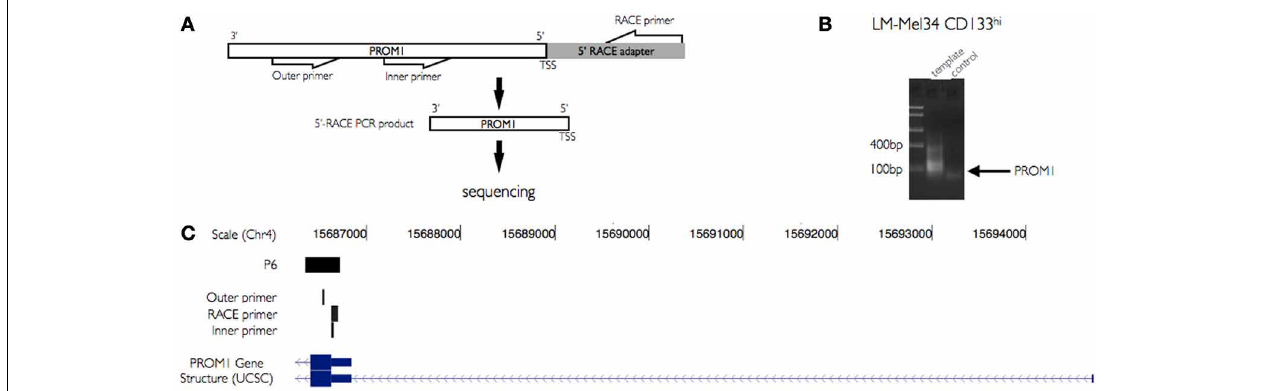
FIGURE 3 | Validation of novel PROM1 TSS using 5 (cid:2) RACE PCR. (A) Schema illustrating primer design for PROM1 TSS validation. PROM1 TSS is amplified using a pair of outer and inner primer sets targeted specifically to 5 (cid:2) Rapid amplification of cDNA ends (RACE) adapter and PROM1 sequences. (B) The 5 (cid:2) end regions of PROM1 mRNA were amplified from CD133 + and CD133 − populations of LM-Mel-34 cell lines. Gel electrophoresis of amplified products shows difference in expression